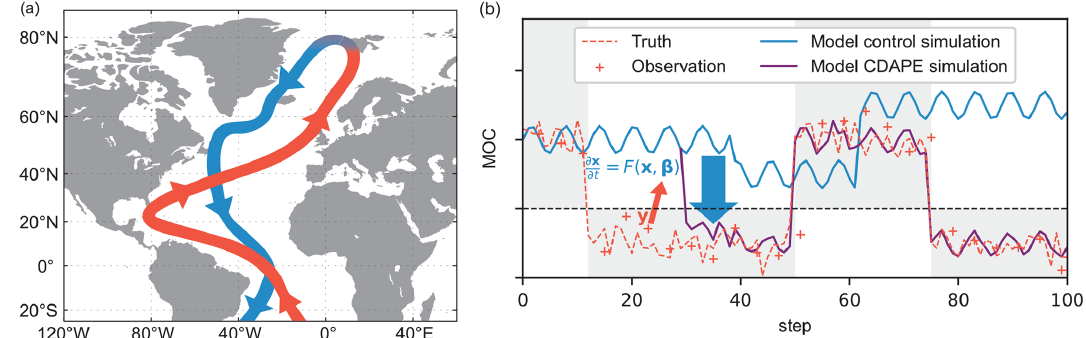
Figure 1. A schematic illustration of capturing AMOC regime transitions by projecting observational information to model states and parameters, by (a) the illustration of the AMOC consisting mainly of upper warmer and saltier northward flow (red) and deep cold southward flow (blue), and (b) the time series of the “observations” (“+” signs) of the ocean, the values of model control simulation (blue line) and observation-constrained simulation by coupled data assimilation and parameter estimation (CDAPE). The red arrow denotes that the “observations” sampled from the truth (dashed red line) are projected onto the model states x and parameters β at nearly step 30. The purple line represents the model simulation results after CDAPE. The blue arrow represents the process of capturing regime transitions. The backgrounds with color of light gray correspond to the “observed” multi-equilibrium transition path. The dashed black line is a division line between different equilibrium states of the